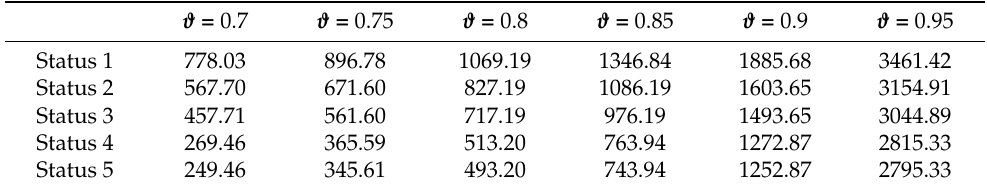
Table A4. Impact of the initial system status and the 𝜗 discount parameter on the discounted profit resulted by the optimized maintenance policy.